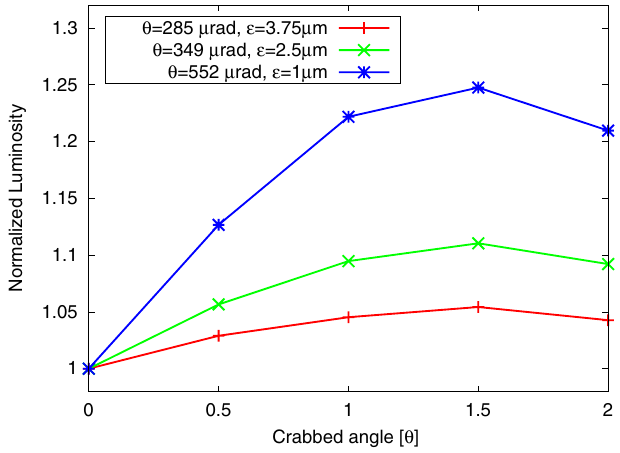
FIG. 16. (Color) Relative luminosity gain (normalized with the corresponding crossing case and the emittance set to 3.75, 2.5, and 1 (cid:7) m rad for the three cases, respectively) for three cases with different beam emittance and bunch intensity (nominal LHC with (cid:5) (cid:3) ¼ 0 : 55 m , (cid:2) ¼ 285 – 552 (cid:7) rad ), from GUINEA- PIG simulations with a single global crab cavity. The luminosity gain is 10%–25% for lower emittance.